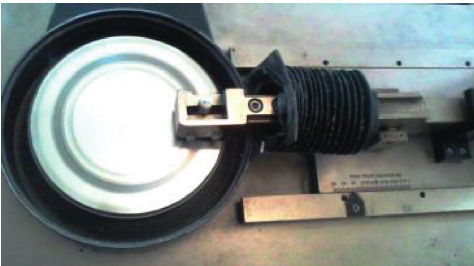
Figure 2: Stir-casting process equipment and setup.